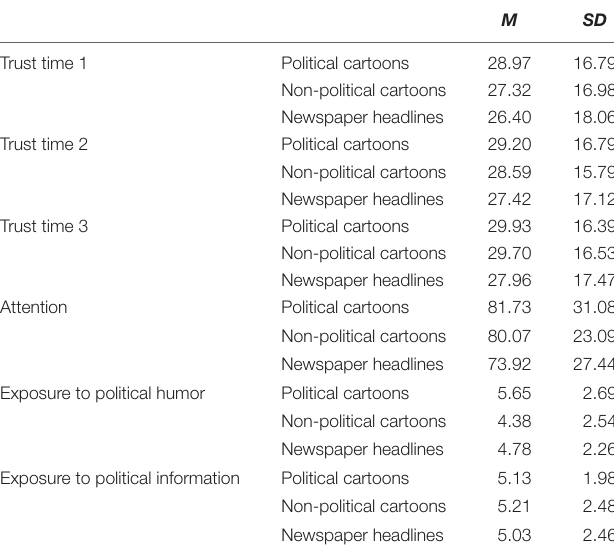
TABLE 6 | Means and standard deviations for trust times 1, 2, and 3, attention, exposure to political humor and exposure to political information (Study